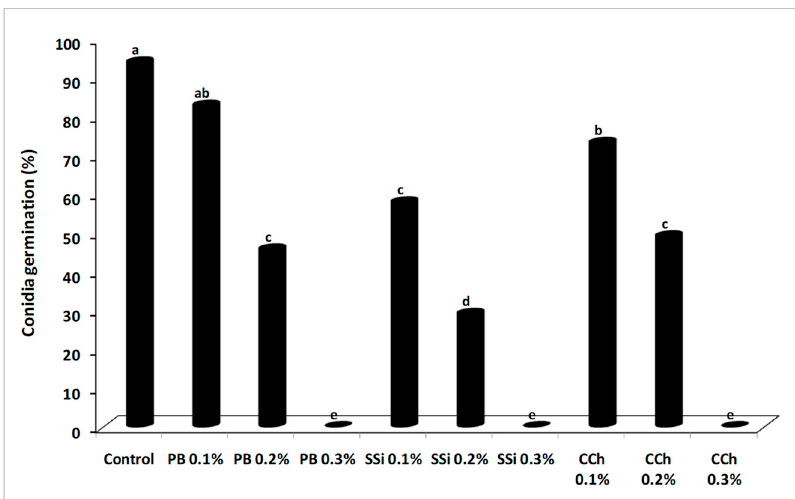
Figure 5. Effect of potassium bicarbonate (PB), sodium silicate (SSi), and calcium chelate (CCh) on conidial germination (%) of Botrytis cinerea in potato dextrose broth after 8 h of incubation at 23 ± 1 °C. Values marked with the same letters are not statistically different by Fisher’s protected least significant difference test at p ≤ 0.05.